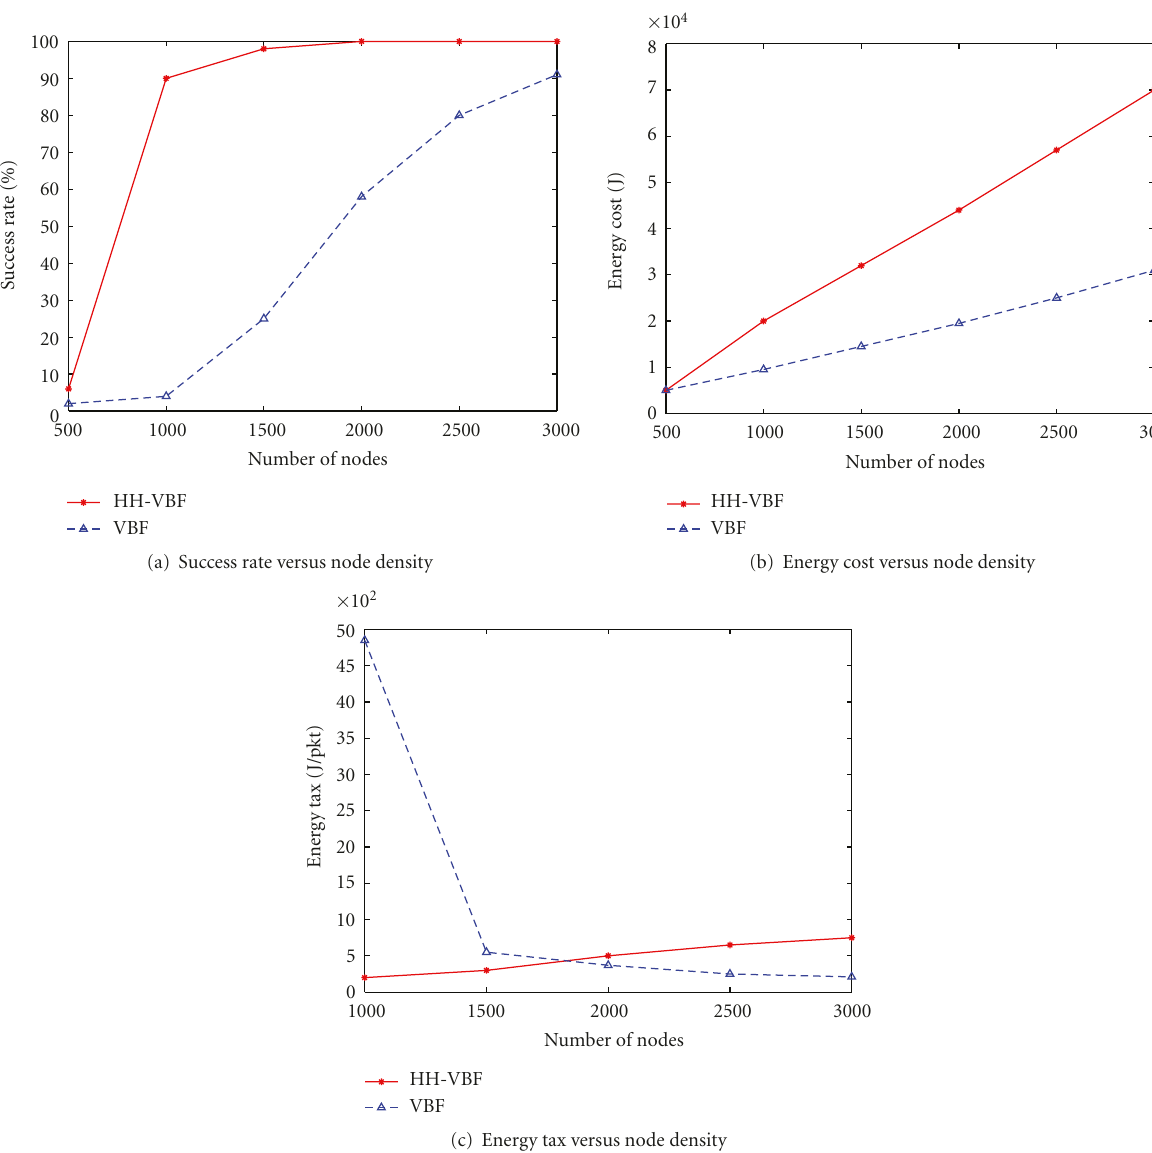
Figure 7: The performance of HH-VBF with varying node